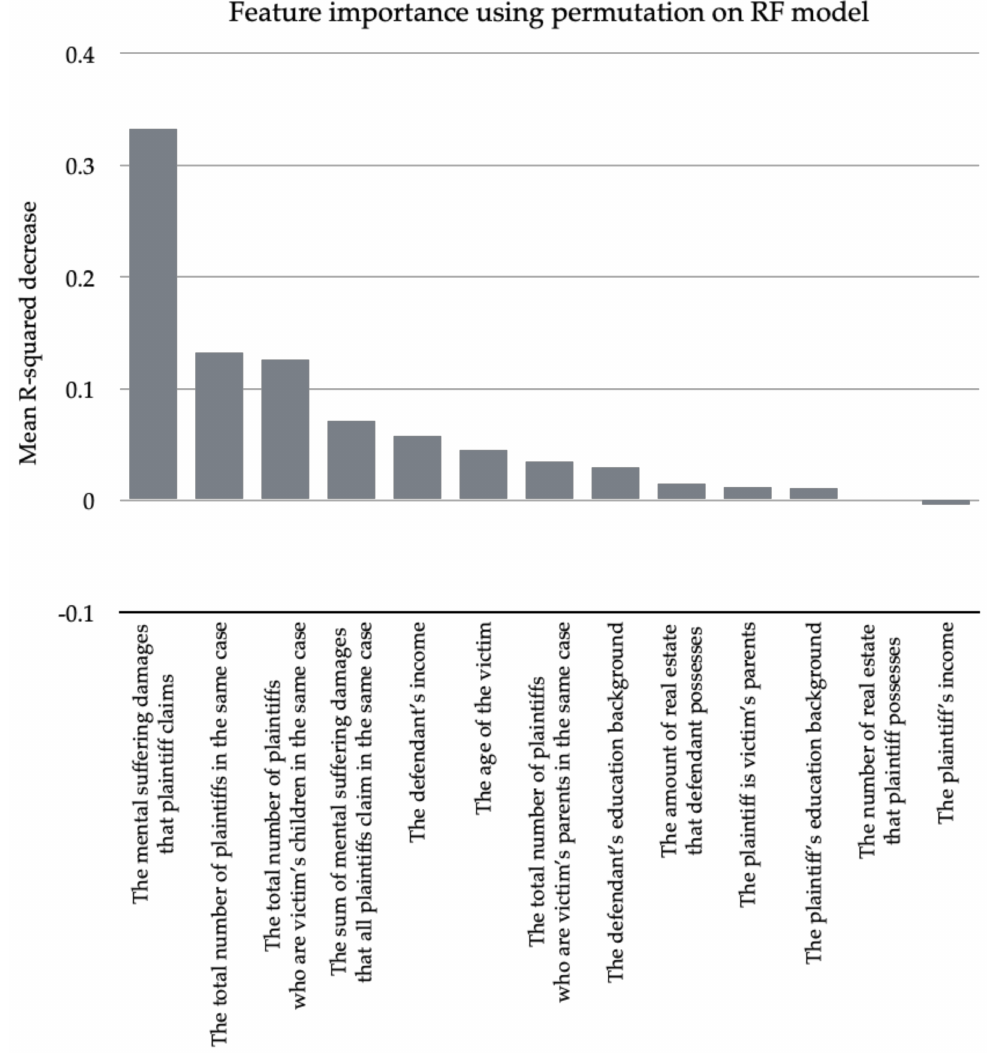
Figure 4. Feature importance using permutation on the RF model. Table 16. Comparison of important